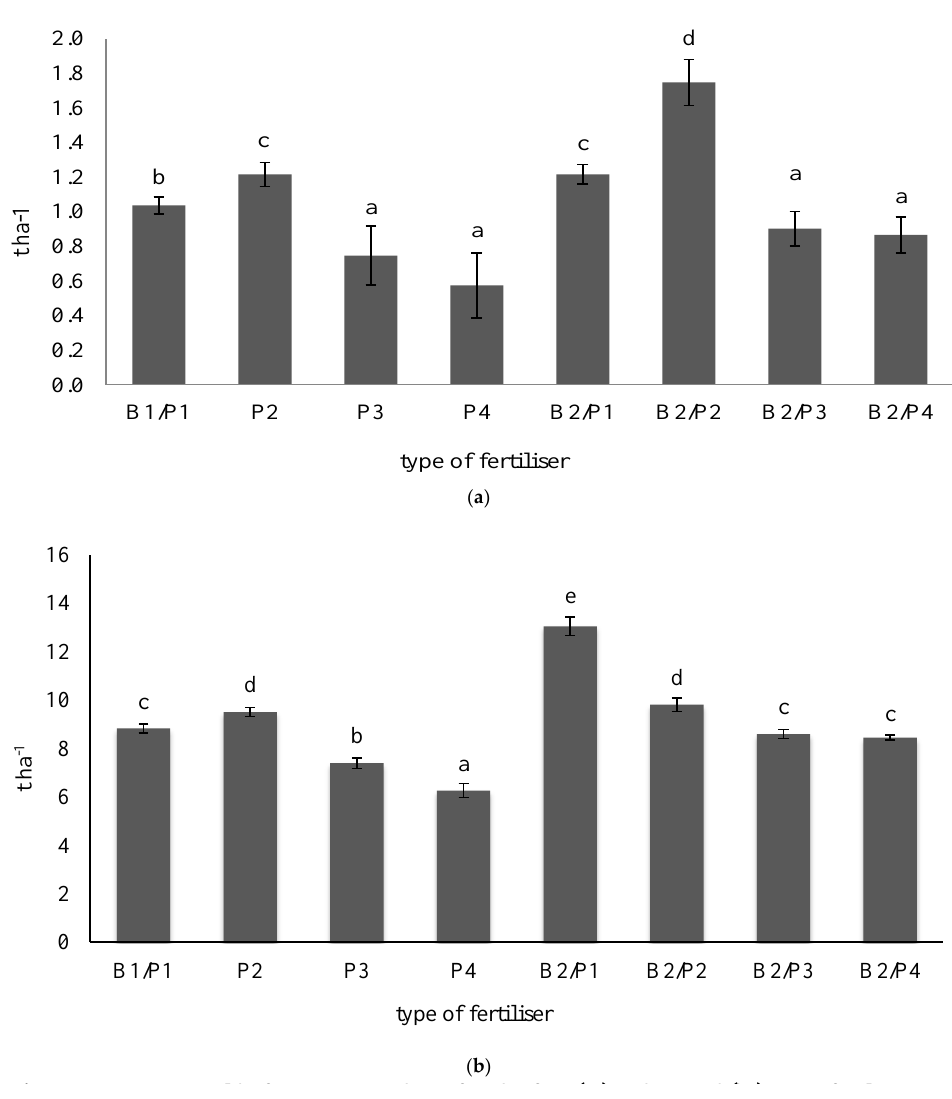
Figure 5. Biomass yield of giant miscanthus after the first ( a ) and second ( b ) year of cultivation, depending on the fertilisation used. Differences between average values marked with the same Arabic letters are not statistically significant at the level of α ≤ 0.05 according to the Bonferroni